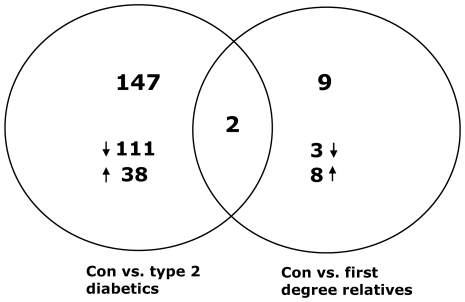
Number of differentially expressed genes.Diagram showing the number of genes found to be differentially expressed in skeletal muscle biopsies from people with type 2 diabetes and first degree relatives compared to healthy controls in a dChip analysis of the generated microarray data. Criteria used in the analysis were set as described in the Methods section. The number of up- and downregulated genes in each group is indicated. Only 2 genes were found to have an altered expression in both groups, namely TncRNA and LDHB. LDHB is a key-enzyme in anaerobic glycolysis and had a reduced expression in both the ‘R’ and the ‘D’ group compared to controls.